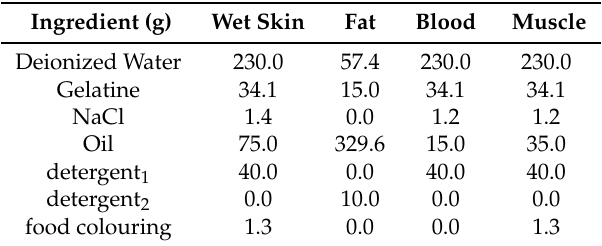
Table 1. Recipes of Tissue-Mimicking Materials including low, intermediate and high water-content tissues from 300 MHz to 20 GHz [26] (food colouring is used to distinguish the